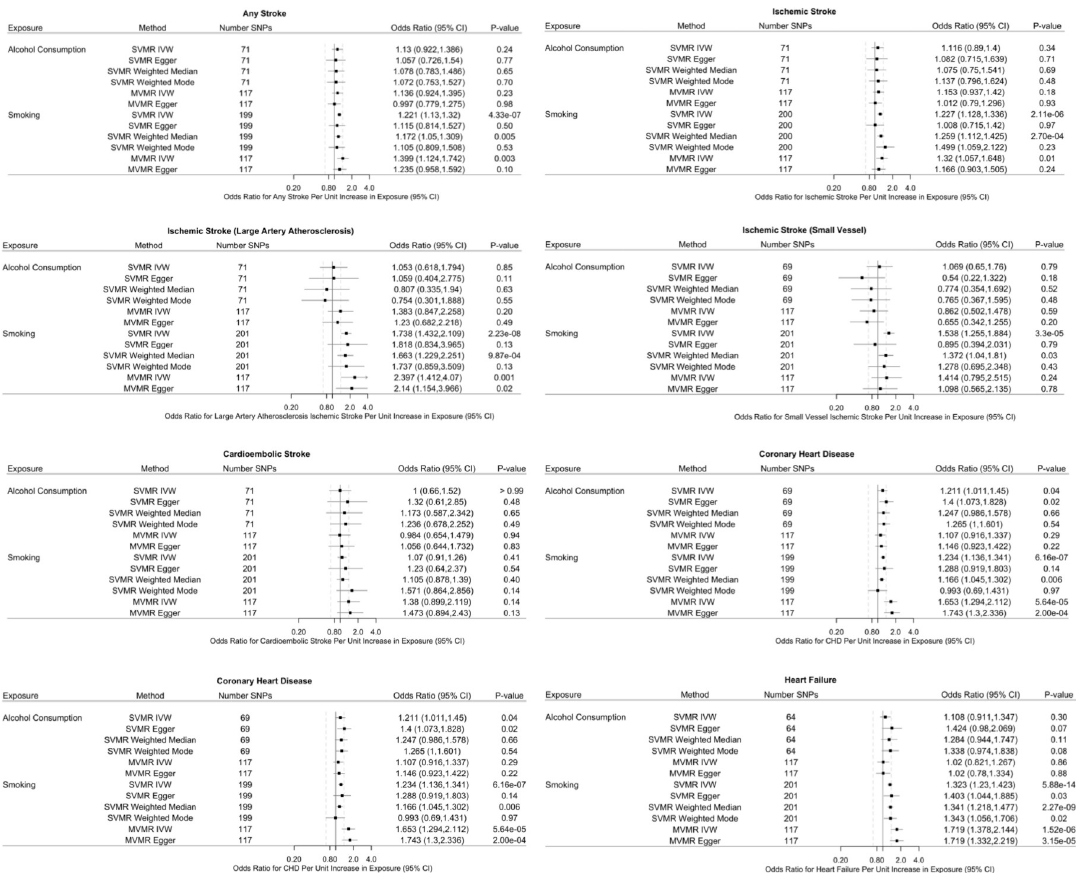
Fig 3. Associations of genetically predicted alcohol consumption and smoking with CVD outcomes. SVMR and IVW MVMR and MR–Egger estimates are shown as ORs. For alcohol, ORs are per 1 SD increase in log-transformed weekly alcohol drinks consumed (MVMR adjusts for smoking). For smoking, ORs are per 1 SD increase in the log odds of smoking regularly (MVMR adjusts for alcohol consumption). CI, confidence interval; CVD, cardiovascular disease; IVW, inverse variance weighted; MVMR, multivariable Mendelian randomization; OR, odds ratio; SD, standard deviation; SNP, single nucleotide polymorphism; SVMR, single-variable Mendelian randomization.